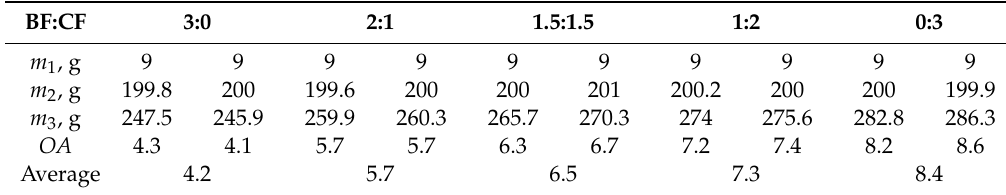
Table 4. Results of the basket leak tests. OA: (oil) absorption rate.